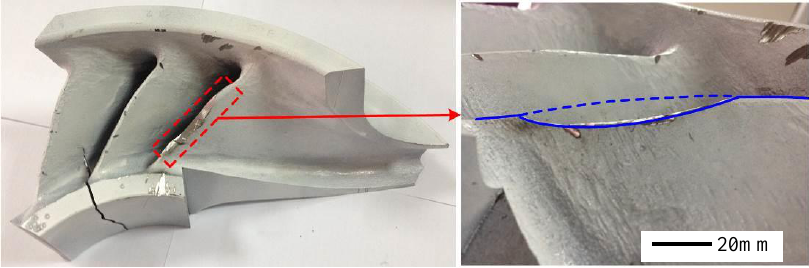
Figure 7. Morphology of blades with preset damage.